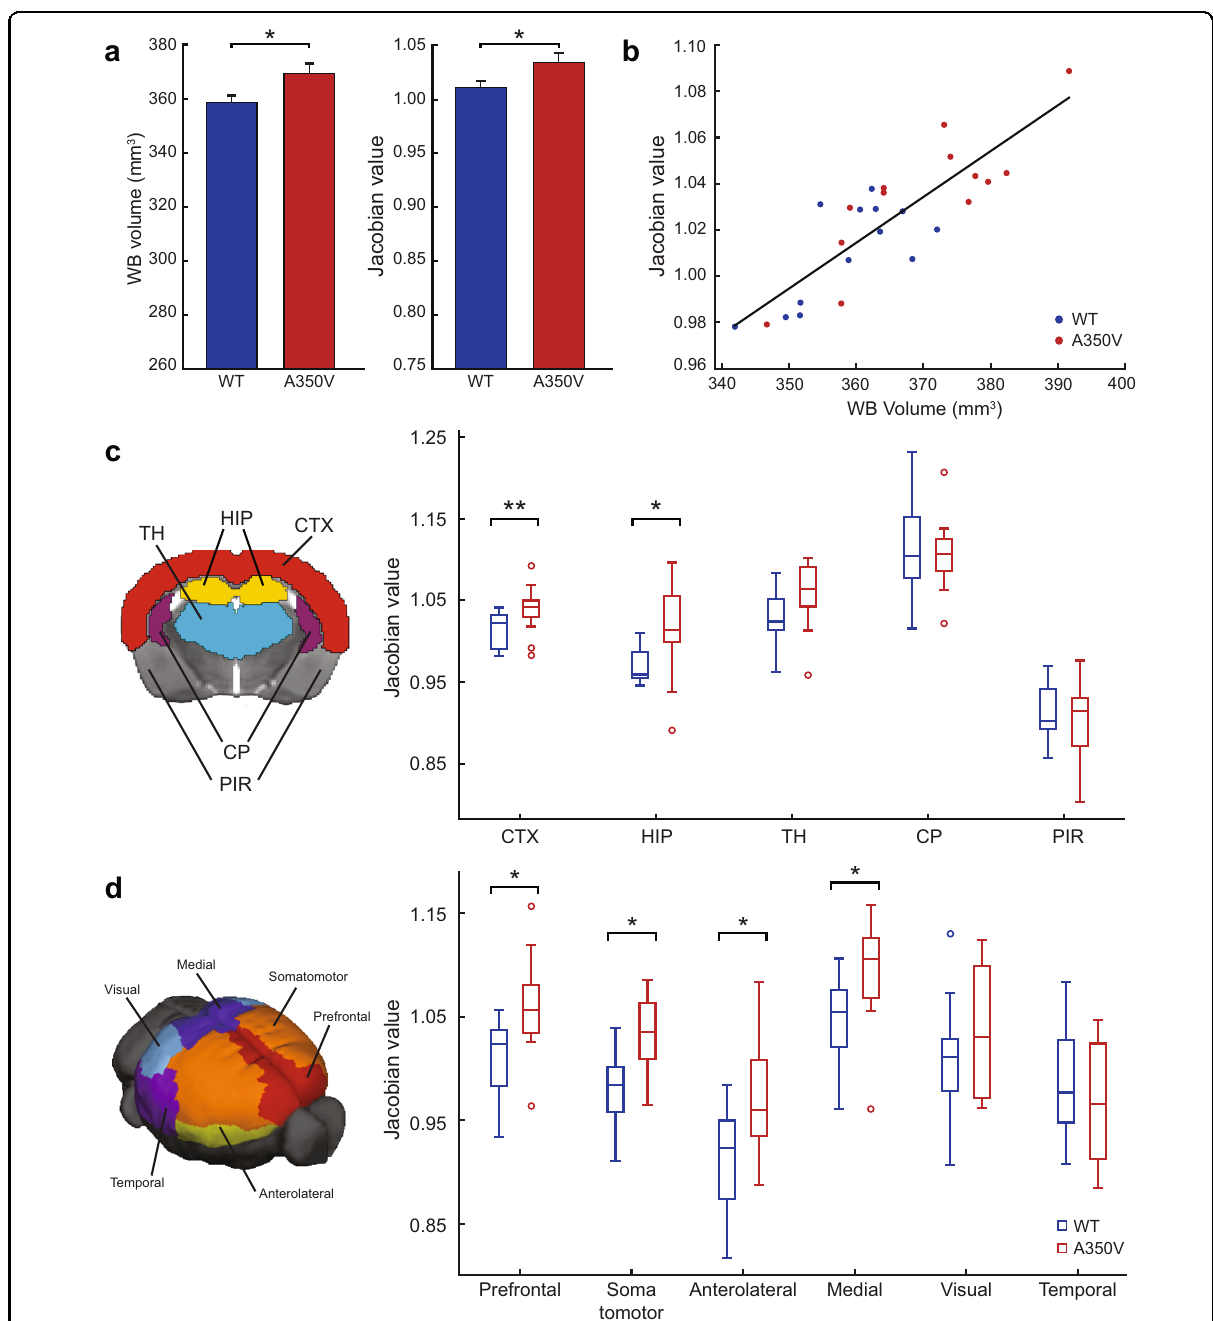
Fig. 2 Structural alterations in A350V IQSEC2 mouse model. a Whole-brain volume increase in A350V mice shown by manual volume quanti fi cation ( left ) and automatic registration evaluation ( right ). b Correlation between Jacobian determinant and whole-brain volume showing an agreement between the two evaluation methods. c Jacobian determinant of the different brain structures depicted on the left indicates increased volume of CTX and HIP in A350V mice. d Jacobian determinant of the six cortical modules depicted on the left indicates increased volume of the Prefrontal, Somatomotor, Anterolateral, and Medial modules in A350V mice. Data indicate mean ± SEM. Boxplots represent the median (center line), interquartile range (box limits), extreme data points (whiskers), and outlier (circles). Mann – Whitney U -test; * p < 0.05, ** p < 0.01, FDR-corrected. CTX cerebral cortex, HIP hippocampal region, TH thalamus, CP caudoputamen, PIR piriform